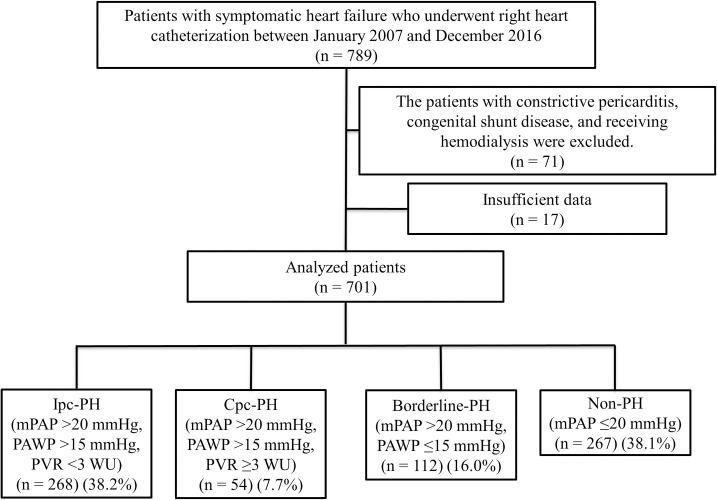
Patient enrollment.Ipc-PH, isolated post-capillary pulmonary hypertension; Cpc-PH, combined pre- and post-capillary pulmonary hypertension; PH, pulmonary hypertension; mPAP, mean pulmonary artery pressure, PAWP, pulmonary artery wedge pressure, PVR, pulmonary vascular resistance; WU, Wood units.